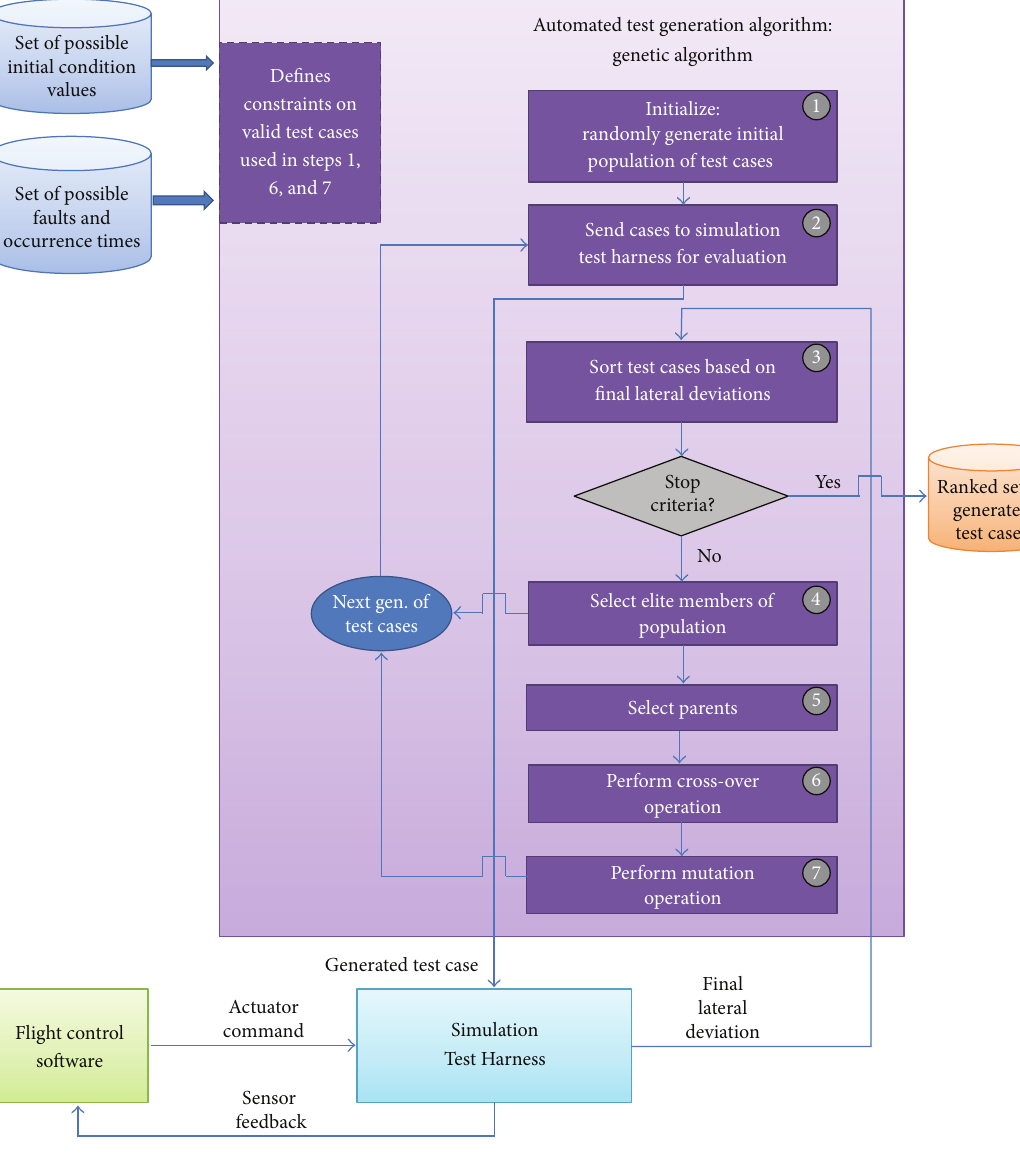
Figure 7: Flowchart of the genetic algorithm automated test generation